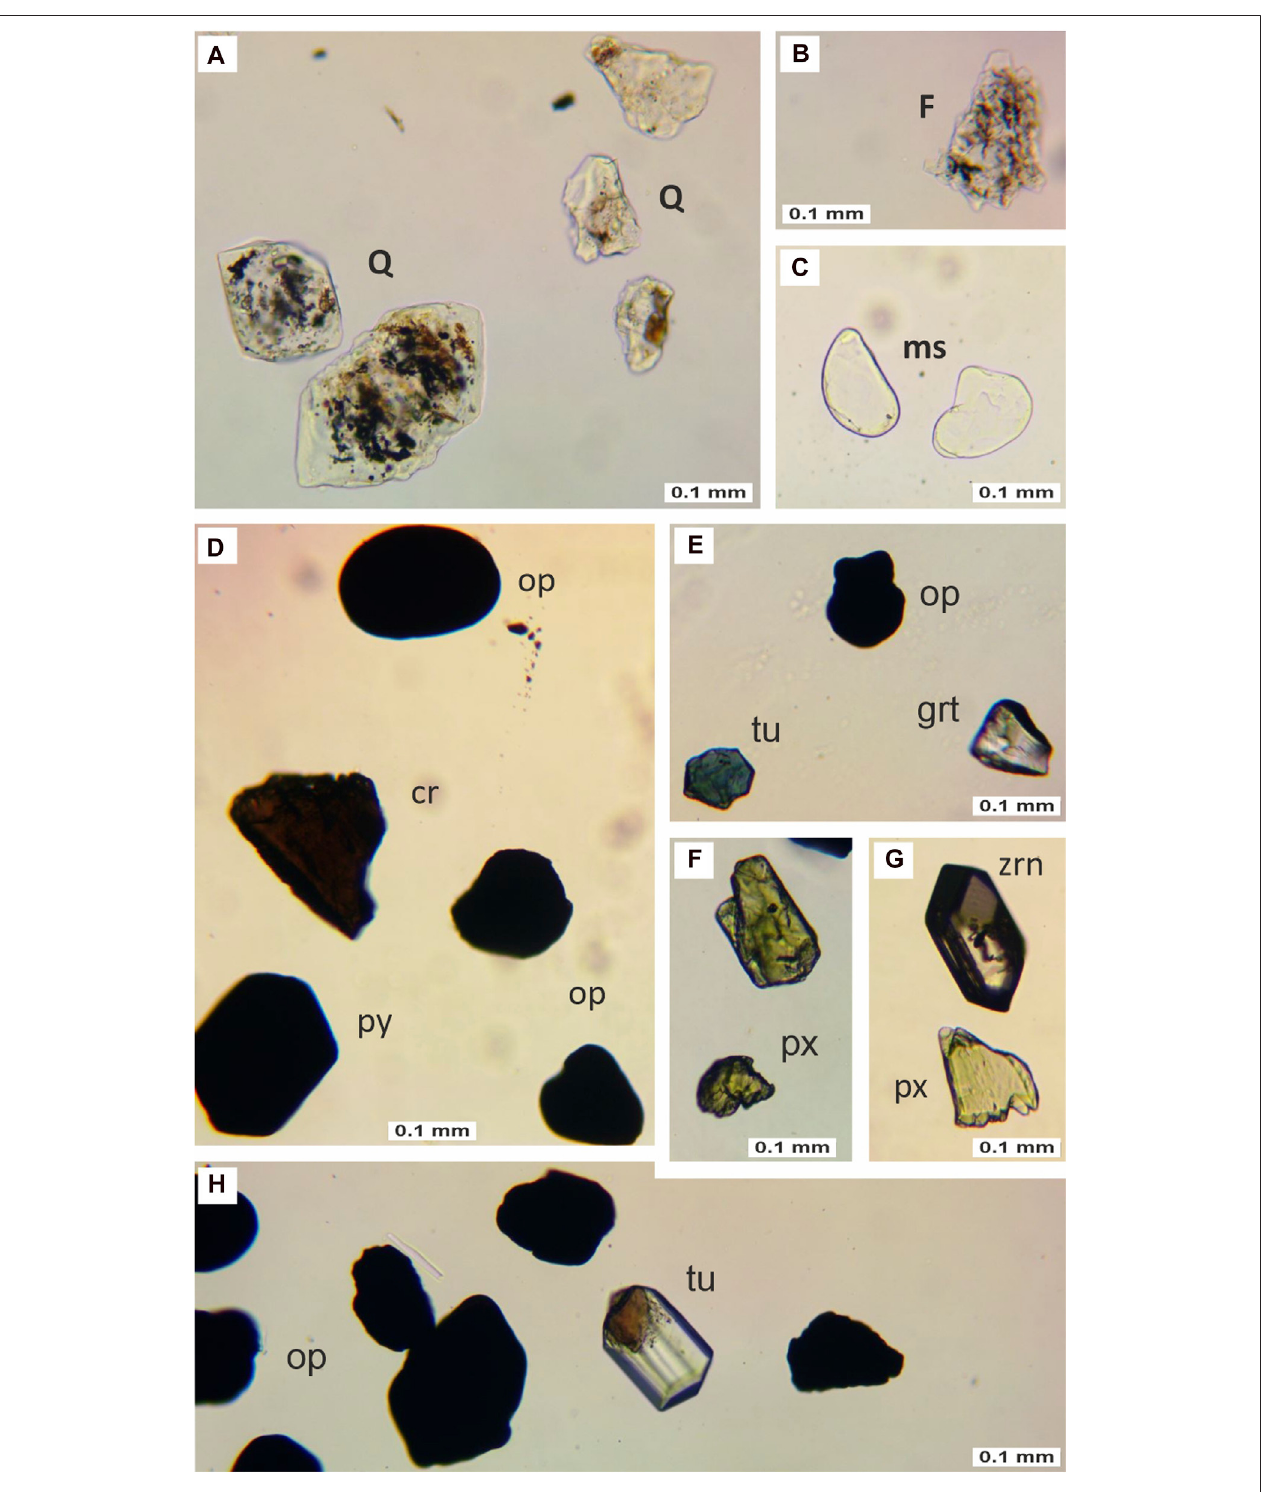
FIGURE 5 | Overview of selected mineral grains from the light and heavy mineral fraction of the DC-SP pro fi le (photo without analyzer). (A) Weakly rounded allotriomorphicandhypidiomorphicquartzgrains(Q)fromsampleDC-SP2, (B) Feldspar(F)fromsampleDC-SP2, (C) muscovitegrains(ms)fromsampleDC-SP7, (D) rounded opaque minerals (op), chromite (cr), and pyrite (py) from sample DC-SP 2, (E) opaque minerals (op), tourmaline (tu), and garnet (grt) from sample DC-SP 6, (F) pyroxenes(px)from sampleDC-SP6, (G) zircon(zrn), and pyroxene(px)from sampleDC-SP2,and (H) opaqueminerals(op)andtourmaline(tu)from sampleDC- SP 3.